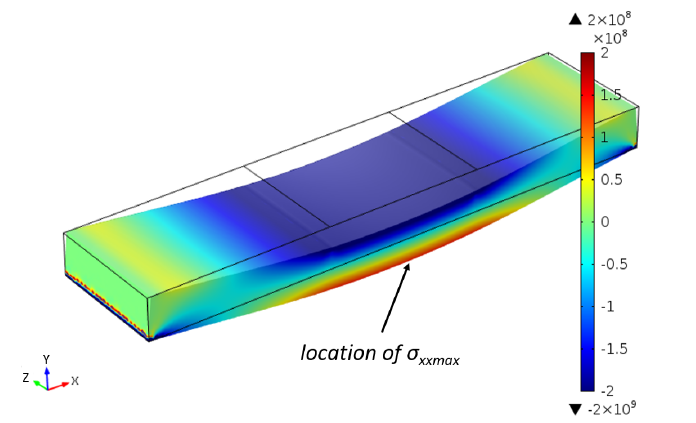
Figure 8. The σ distribution map of four-point bending test (unit of color scale bar: Pa). xx